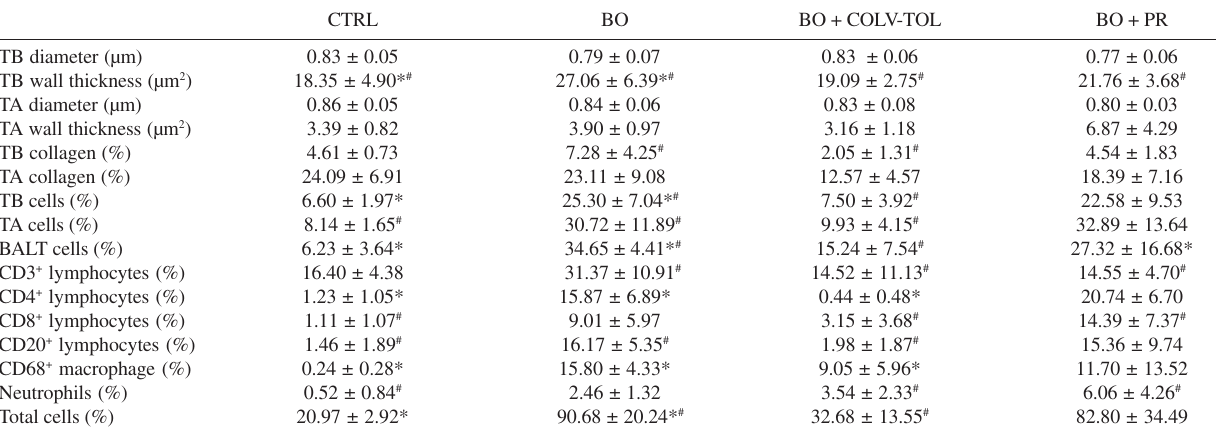
Table 1 - Measurements of terminal bronchioles, terminal arteries, peribronchovascular collagen, and immune cells in the 4 experimental groups of animals (mean ±